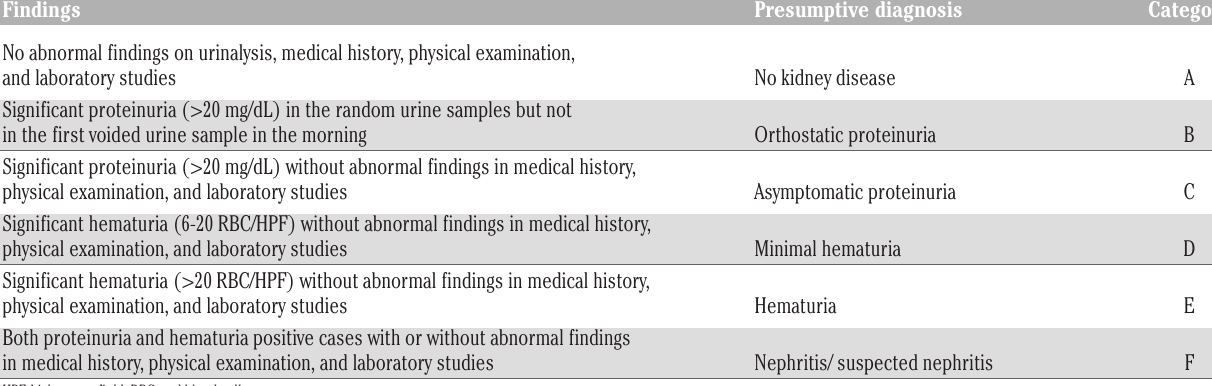
Table 1. Criteria of diagnoses in the urinary screening program in Japan.